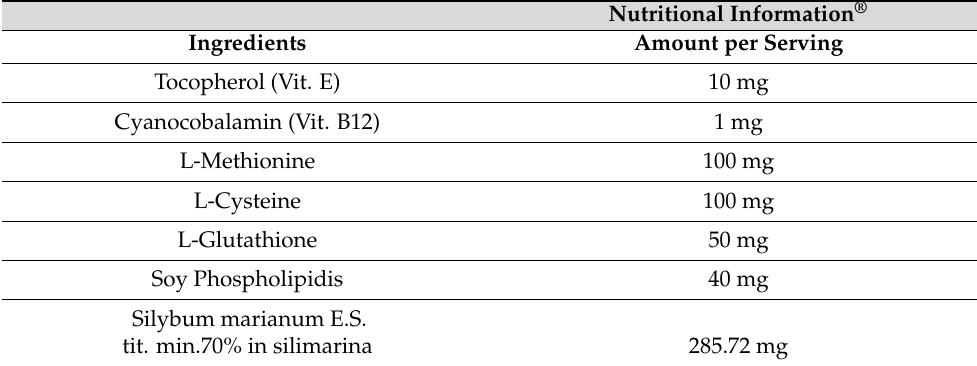
Table 1. Chemical composition of nutraceutical capsules.